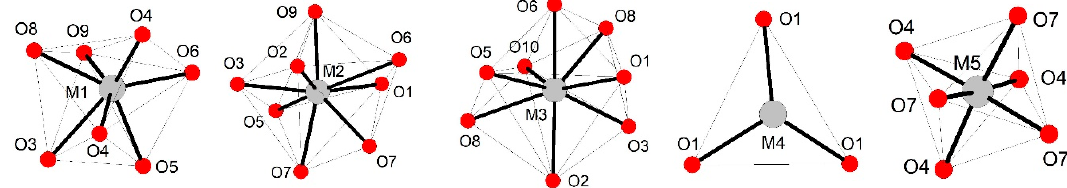
Figure 3. Coordination environments around the M1–M5 cationic sites in Me β –TCP.